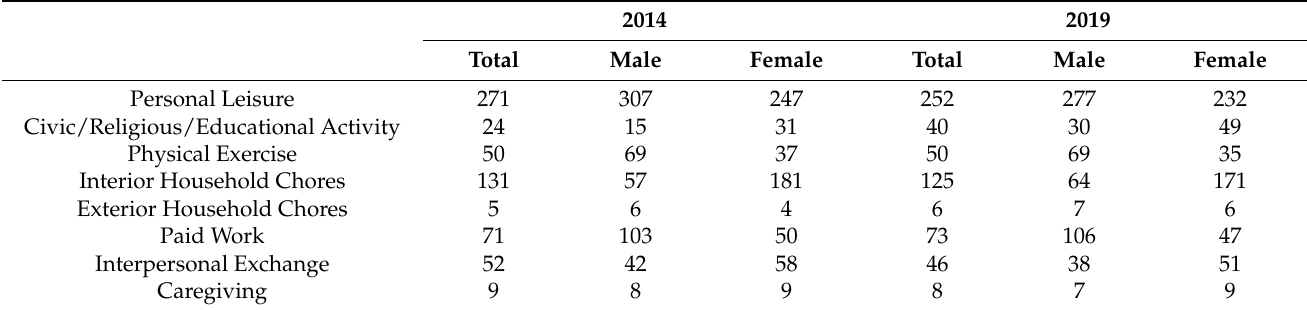
Table 9. Average time spent for each activity domain by gender (measured as minutes per